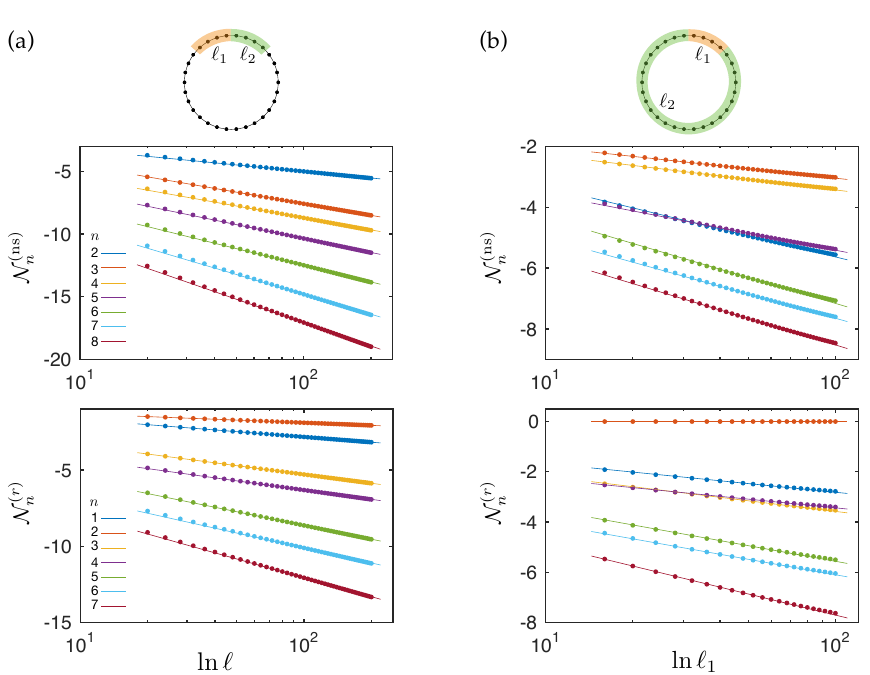
Figure 2: Comparison of numerical (dots) and analytical (solid lines) results for the scaling behavior of the moments of partial transpose (48) in the up row and (50) in the down row for two subsystem geometries: (a) two adjacent intervals, and (b) bipartite geometry. In (a), intervals have equal lengths (cid:96) on an infinite chain. In (b), the total system size is L = 400 and 20 ≤ (cid:96) ≤ 100. Different colors correspond to different moments n